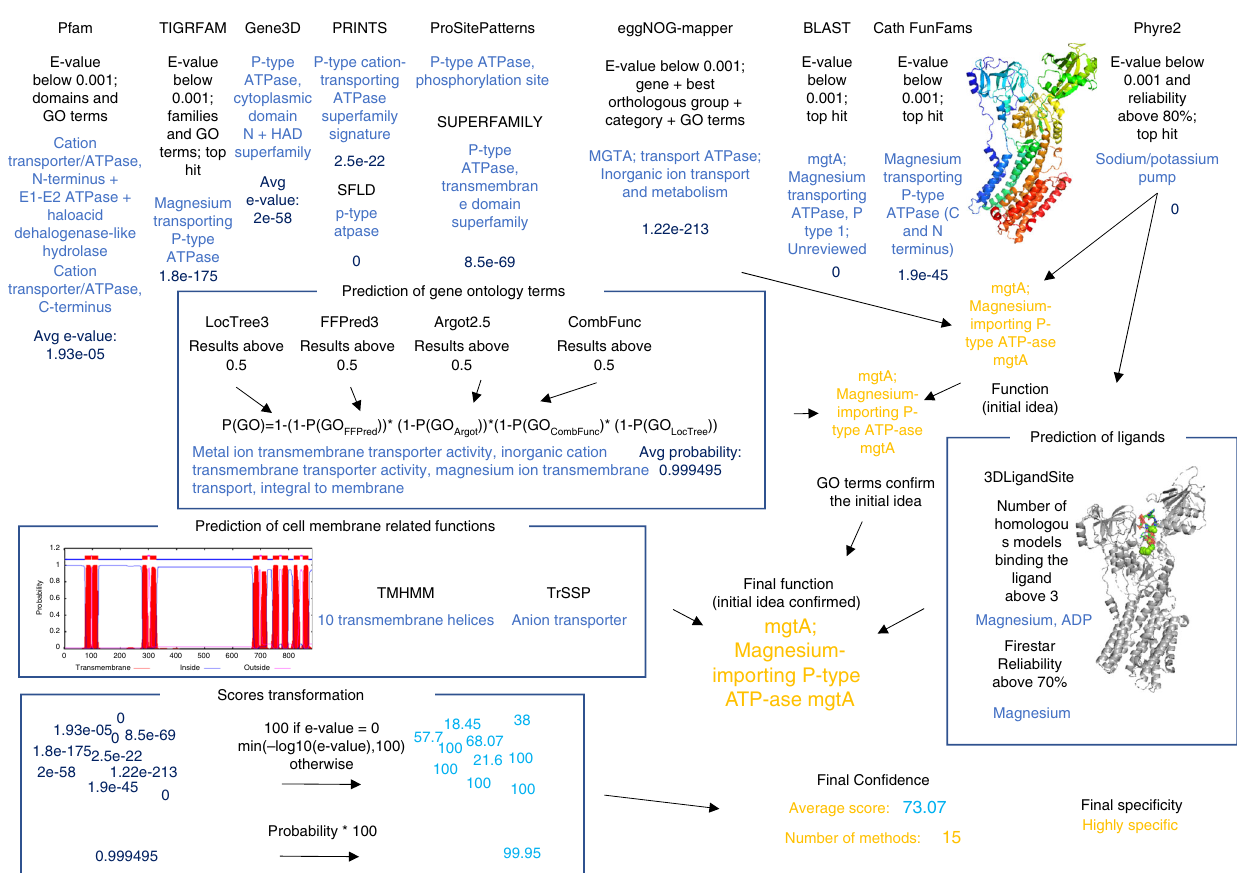
Fig. 4 Assigning function to proteins in the minimal genome. The fl owchart outlines how functions were assigned to the proteins using MMSYN1_0879 as an example. The top row of methods are used to identify a likely function. The methods in the three groups of boxes (predicted GO terms, ligand binding predictions and membrane protein predictions) are then used to see if they support the function identi fi ed by the fi rst group. Where the fi rst group does not predict a function then this second group was used. The fi gure shows the results obtained for MMSYN1_0879, which was annotated as the gene